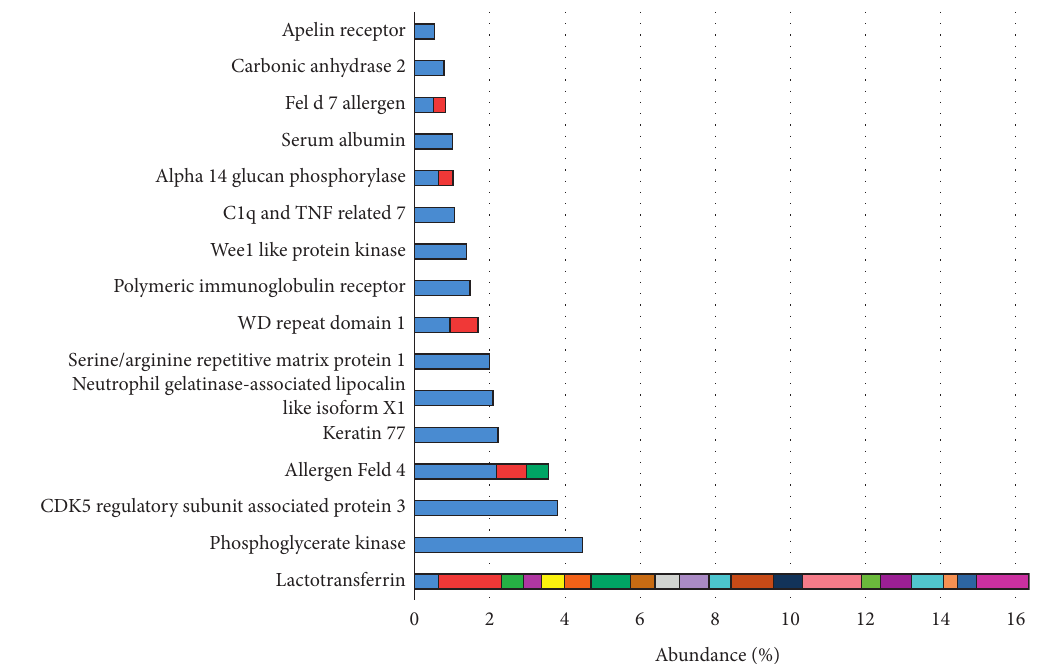
Figure 2: Graphical representation exposing the distribution of proteins and their abundances (%), which can be considered a signature for the protein composition of tear film of healthy cats. The different colors in the abundance bars refer to the different spots where the same protein was identified, that is, for each protein, there is a bar with the sum of all the abundances found for itself.